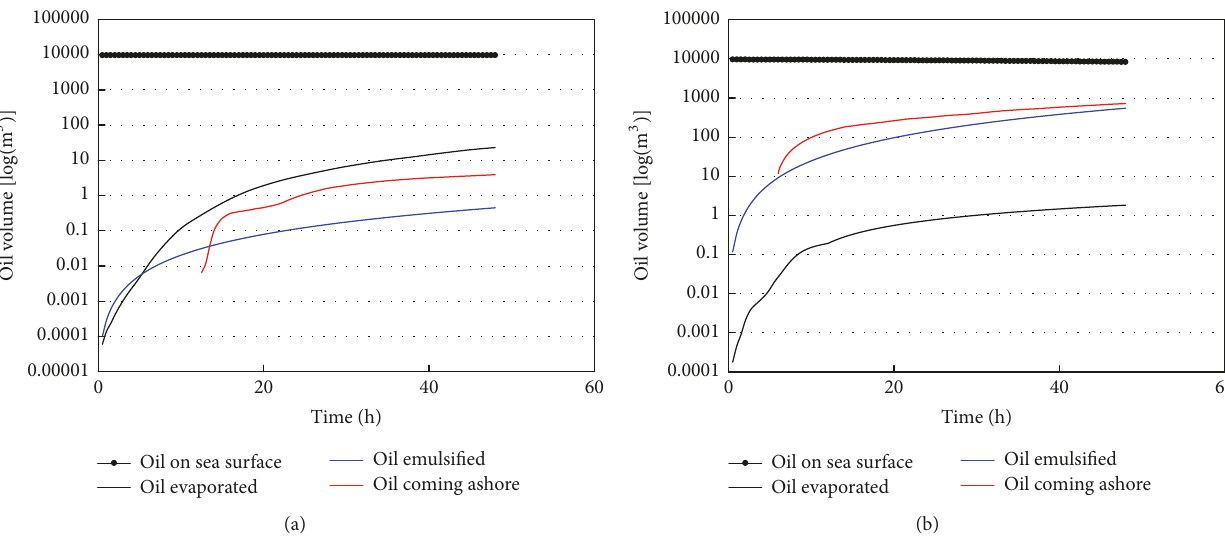
Figure 27: Fate processes of the instantaneous oil spill that occurred in the west of the channel in the case without wind (a) and in the east of the channel under the action of northwest wind (b).